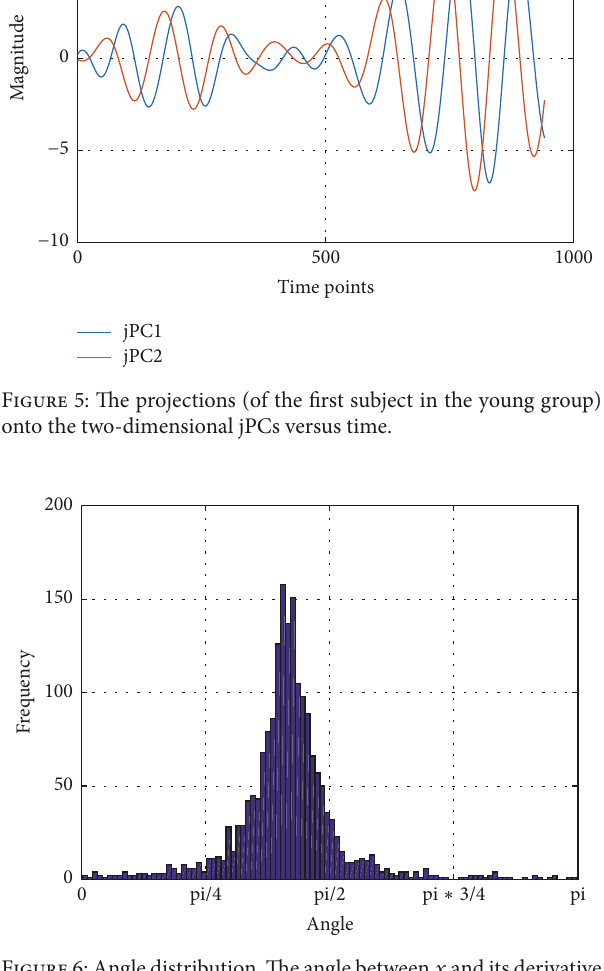
Figure 6: Angle distribution. The angle between 𝑥 and its derivative of the first subject in the young group at band slow 4